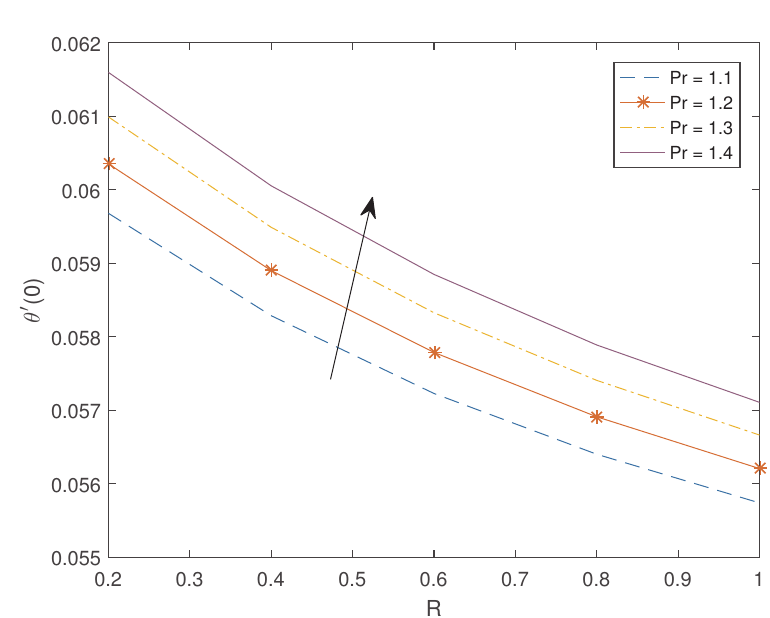
Figure 20. Influence of R and N t on the skin friction.